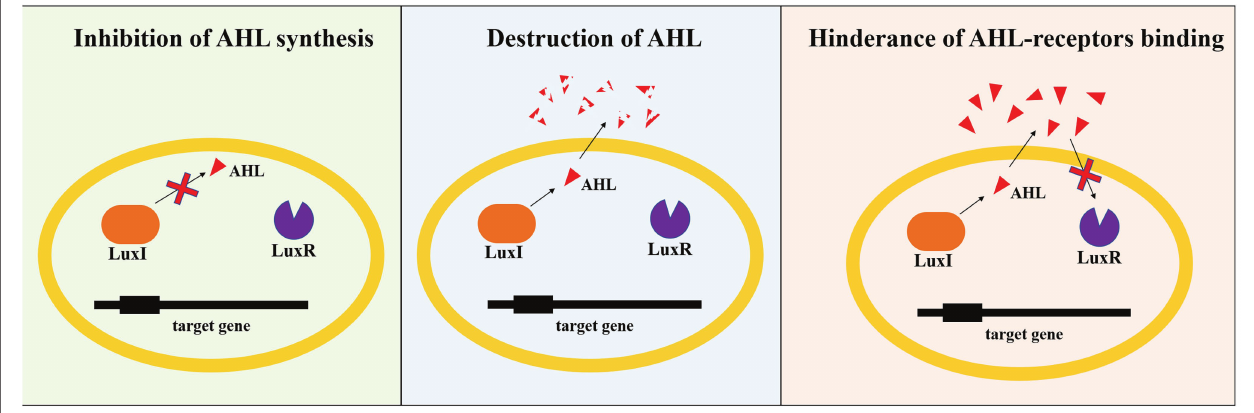
FIGURE 3 | There major types of AHL-mediated quorum